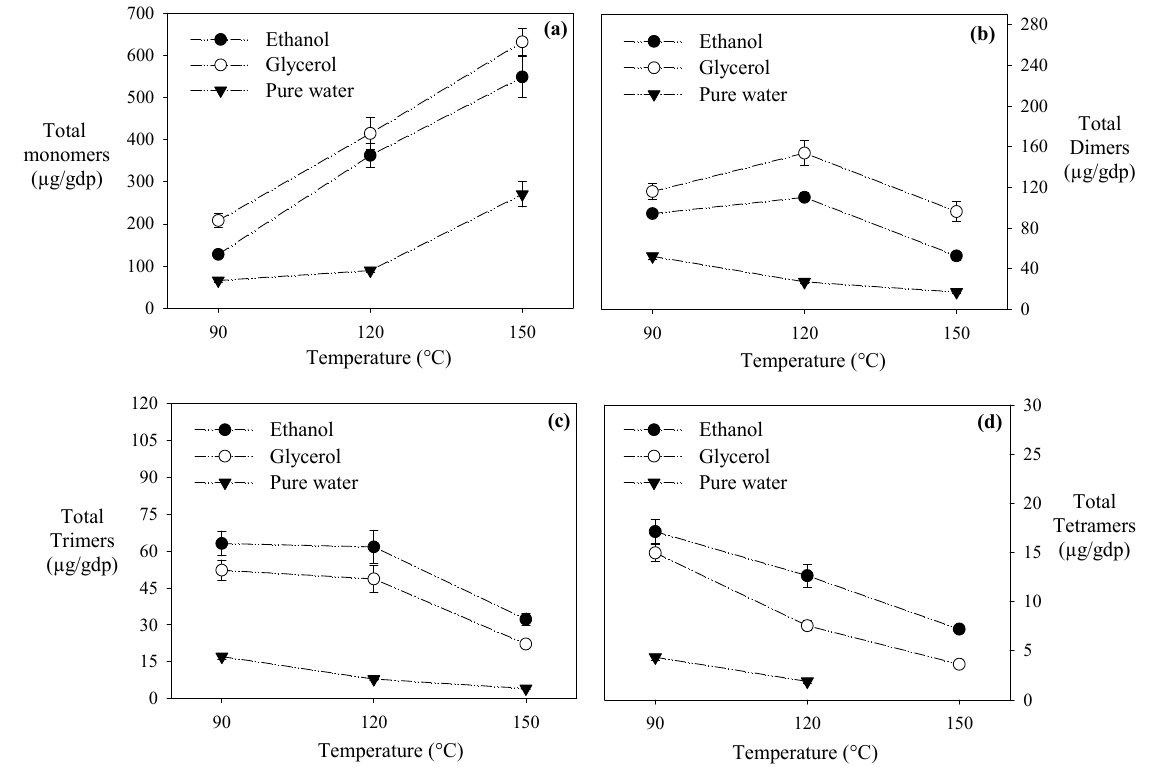
Figure 2. Effect of temperature and solvent extraction on the polyphenols obtained by HPLE. ( a ) Total monomers, ( b ) total dimers, ( c ) total trimers, and ( d ) total tetramers.